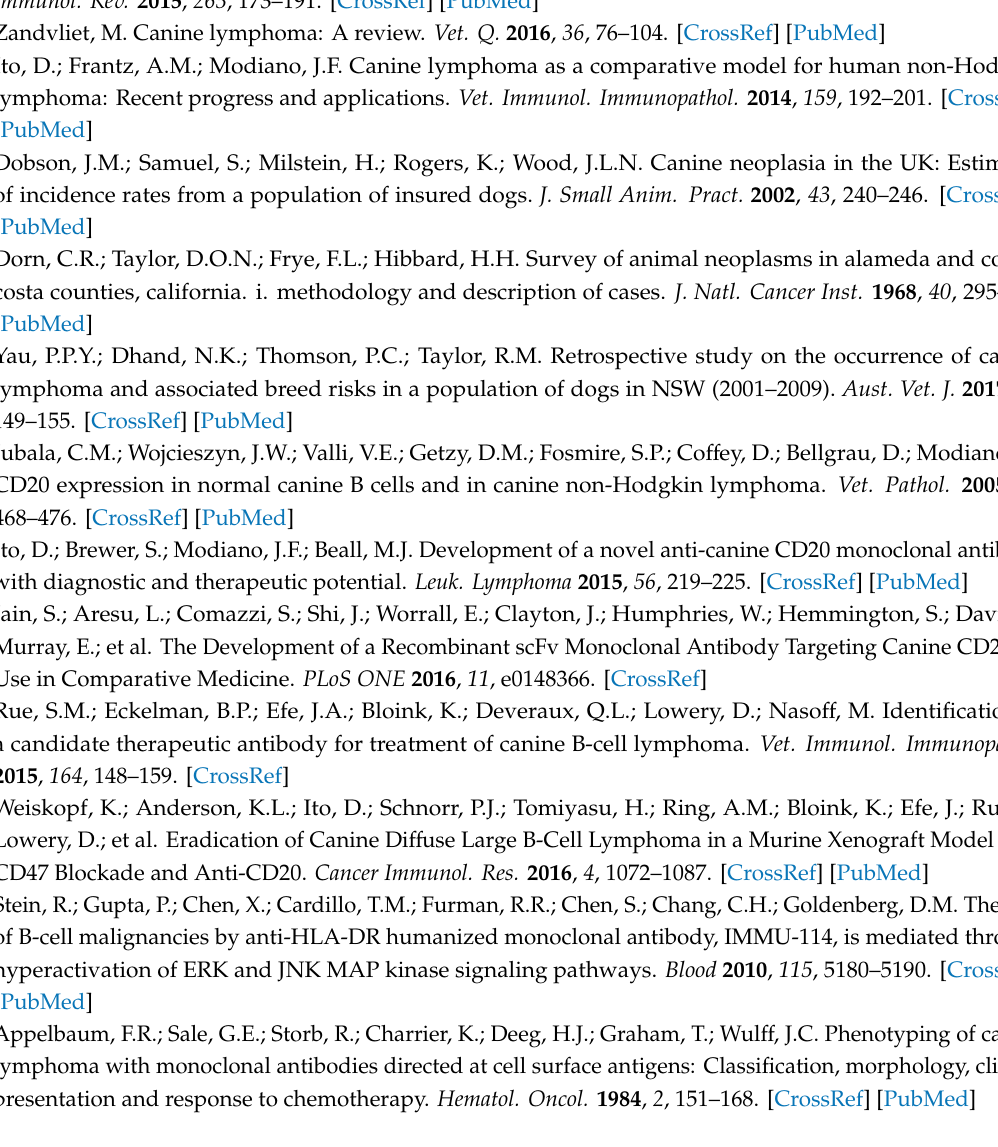
analysis, Table S1: Haematological analysis of the whole blood of tumor-bearing NOD-SCID mice, Table S2: Clinical description of oncologic canine patients, Table S3: raw absorbance data of anti-sDLA-DR ELISA used for the ROC